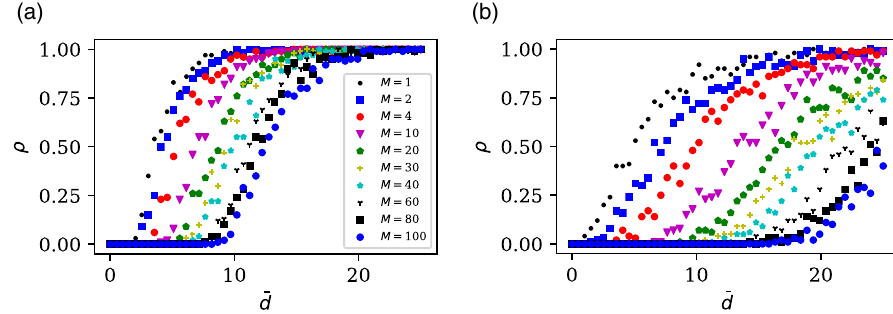
FIG. 6. The structural invertibility of (a) Erd ő s-R´enyi random graphs and (b) scale-free networks (power law exponent γ ¼ 2 . 4 ) ¯ d . For each data point, an ensemble of 100 networks with N ¼ 10 3 nodes is simulated, and disjoint depends on the average node degree sets of M ¼ P input and output nodes are chosen by uniform random sampling. Each network is tested for structural invertibility, and the fraction ρ of invertible networks in the ensemble is recorded. For large networks with many nodes N → ∞ and fixed average degree ¯ ¯ d; N; M Þ asymptotically approaches ρ ð d; M Þ . We find empirically that N ¼ 10 3 is a good approximation for this the function ρ ð asymptotic